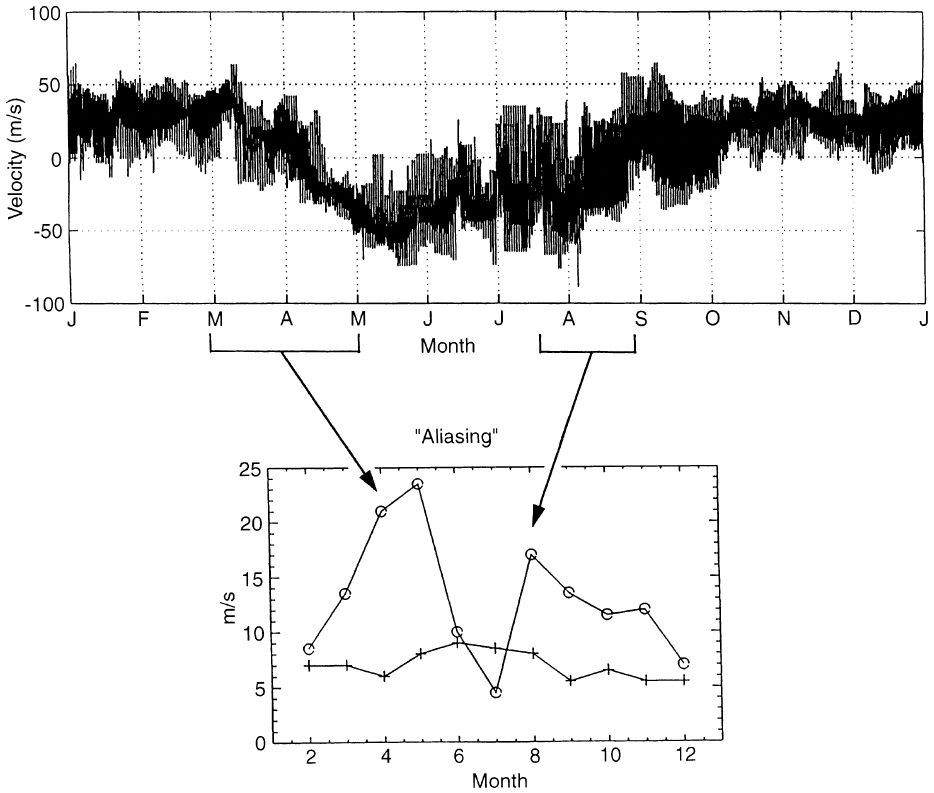
represent the hypothetical lines of exact agreement between the space-based and ground-based determina- tions. The standard deviations of the space-based determinations from these lines, starting at the upper left and moving clockwise, are: 4.48, 10.91, 3.48, and 8 : 60 m/s. Also provided in the upper left of each panel are the corresponding linear correlation coe(cid:129)cients